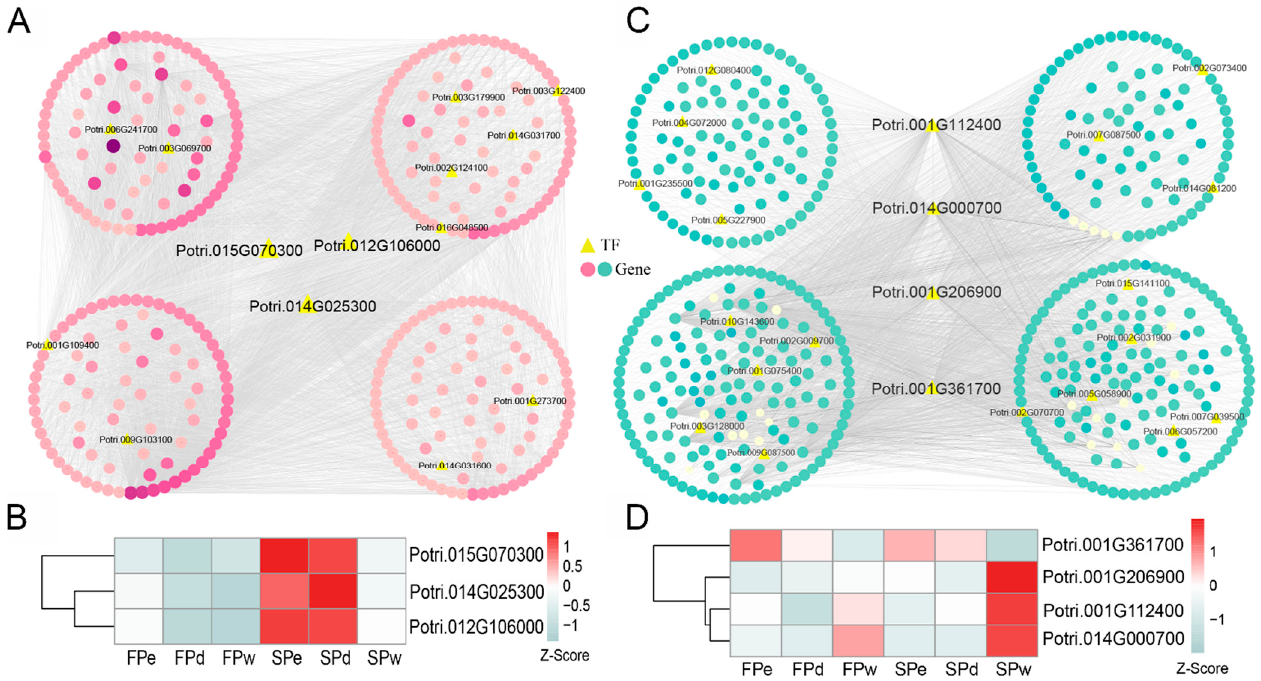
Figure 5. Identification of hub genes in the co-expression network and heatmap of hub genes expressions in the “Brown” and “Purple” modules under shade. ( A ) Three hub genes in the “Brown” module and their connectivity with co-expressed genes in the network. ( B ) Heatmap of hub genes in the “Brown” module. ( C ) Four hub genes in the “Purple” module and their connectivity with co- expressed genes in the network. ( D ) Heatmap of hub genes in the “Purple” module. (The darker and the thicker the line, the stronger the correlation (weight value) between genes in the module. The larger the node, the darker the color, which indicates that the correlation (weight value) between genes is becoming stronger in the module. TF represents transcription factor).